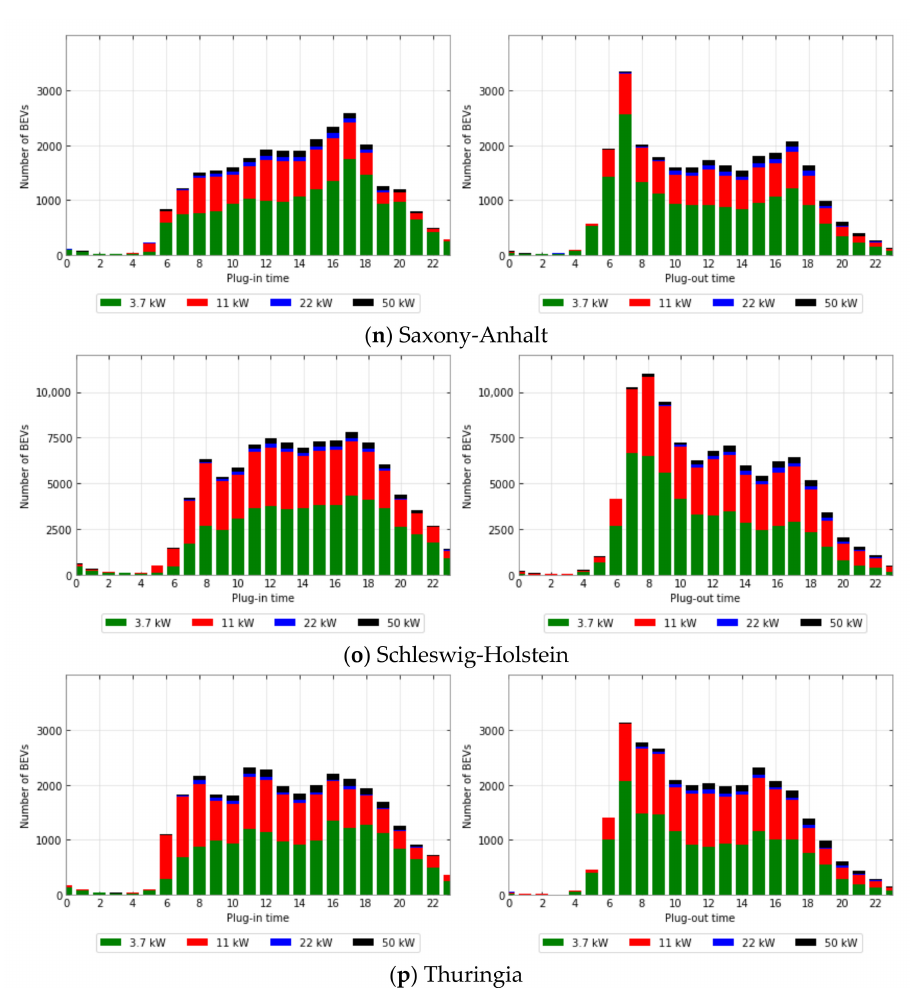
Figure A1. ( a – p ) Plug-in and plug-out times taking into account the charging power used per state. • Charged energy per Federal State [MWh]